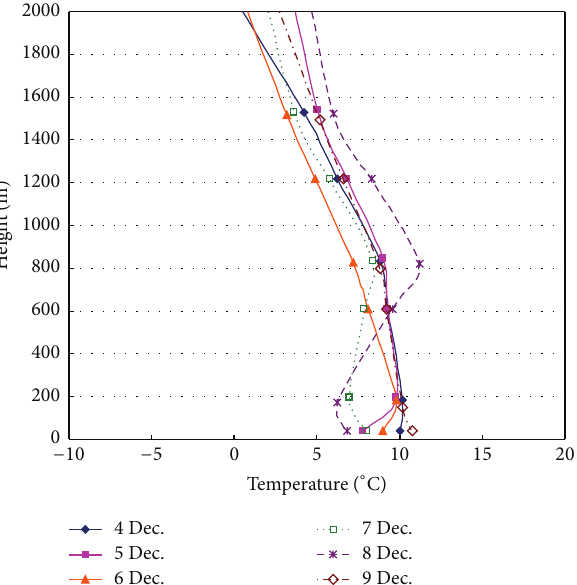
Figure 8: Temperature soundings at Hangzhou station at 08:00 (local time) on 4 ∼ 9 Dec. 2013 (from http://weather.uwyo.edu/upperair/